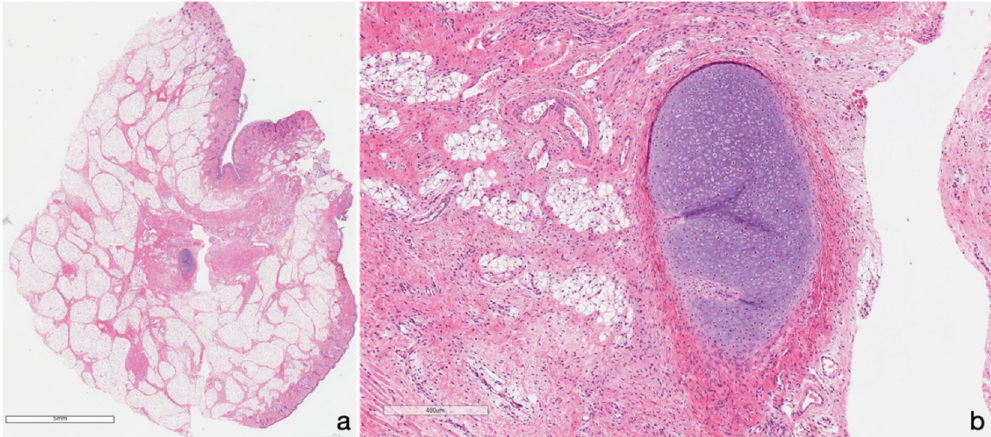
Figure 2. The newborn underwent surgical trans-oral mass removal, with consequent prompt recovery during hospitalization. Non-residual mass was detected during the radiological follow-up. The histologic assessment confirmed MRI suspicion, revealing a stratified keratinized epithelium mass, containing dermal skin appendages as sebaceous and sudoriferous glands, mixed to adipose tissue ( a ) with a small cartilaginous fragment (as shown in detail in b ), consistent with hairy polyp (also known as dermoid polyps (DPs)). It is a benign epithelial inclusion cystic lesion [1–7] resulting from abnormal separation of ectoderm and neuroectoderm along the lines of embryonic fusion, during the first steps of embryogenesis, between the third–fifth gestational week [6,7]. Dermoids may occur in the head and neck region, in particular, settled in the orbital region, nasal dorsum, mouth floor, infratemporal fossa, nasopharynx, oropharynx, and anterior and lateral part of the neck, also arising from the eustachian tube [3], although they may be found anywhere on the body [5]. DPs are frequently found in the neonatal period, but occasionally they can be seen in older children, since a DP’s clinical presentation depends on the site of origin and on its size [2]. When in the naso-oropharyngeal cavity, as in our case, DPs can represent a rare cause of upper airway obstruction, ranging from intermittent symptoms or even respiratory distress [1,2]. Other clinical presentations described are feeding disorders with vomits, hemoptysis, hearing loss, otorrhagia, snoring, and recurrent ear infections [1,8]. Pregnancy could be normal, but polyhydramnios can still occur because of the obstruction of the swallowing mechanism, as in our case [2,9]. Although most of these lesions are superficial, variable rates of intracranial extension have been reported [5,10], above all, in those of the midline neck, which have also been associated with cranial or spinal dysraphism [5,11]. The case discussed above reported an oropharyngeal DP, occupying the space between the epiglottis and the uvula; despite its midline setting, it had neither intracranial extension nor dysraphisms. In addition, DPs are rarely associated with other congenital abnormalities, such as facial hemihypotrophy, ankyloglossia, cleft palate, absent uvula, auricle deformities, or left carotid artery atresia [2], so congenital malformations should be investigated. In our case, the physical examination was normal, and further investigations detected all associated anomalies. The standard of DP management when symptomatic is excision without disruption of the cyst wall. Indeed, if the cyst wall is ruptured at the time of surgery, the remnant tissue should be removed using curettage and copious irrigation [5]. DP prognosis has been shown to be excellent, without recurrence after excision [2,6], as reported in our case. This case report adds another case of this rare pathology to the literature. DPs should be kept in mind in case of newborn respiratory failure. Despite their benign histopathological nature, DPs may be life threatening, since they represent one of the most unusual causes of airway obstruction.